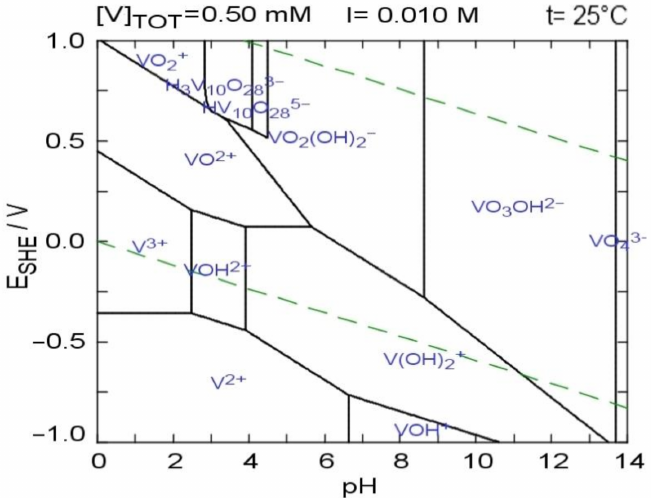
Figure 5. Pourbaix (Eh–pH) diagram for vanadium (V) species. Dashed lines represent the upper (oxygen generation) and the lower (hydrogen formation) stability limits of